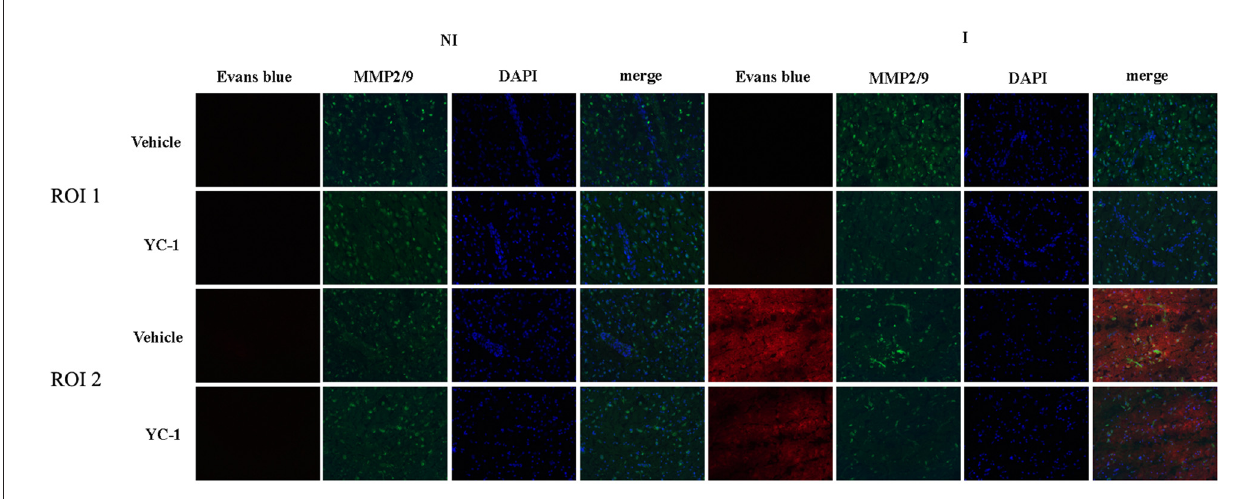
FIGURE 3 | Effect of 3-(5’-Hydroxymethyl-2’-furyl)-1-benzyl indazole (YC-1) treatment on 2-h ischemia-induced BBB damage and MMP-2 induction. Rats received YC-1 at 24 h and 30 min before the onset of ischemia. Evan’s blue (EB) leakage (red) was seen in the ischemic region of interest 2 (ROI 2) after 2-h ischemia and in situ zymmography showed increased MMP-2 activity in the brain area where EB leakage occurred. Pretreatment with YC-1 significantly prevented MMP-2 induction as well as EB leakage. n = 3/group.